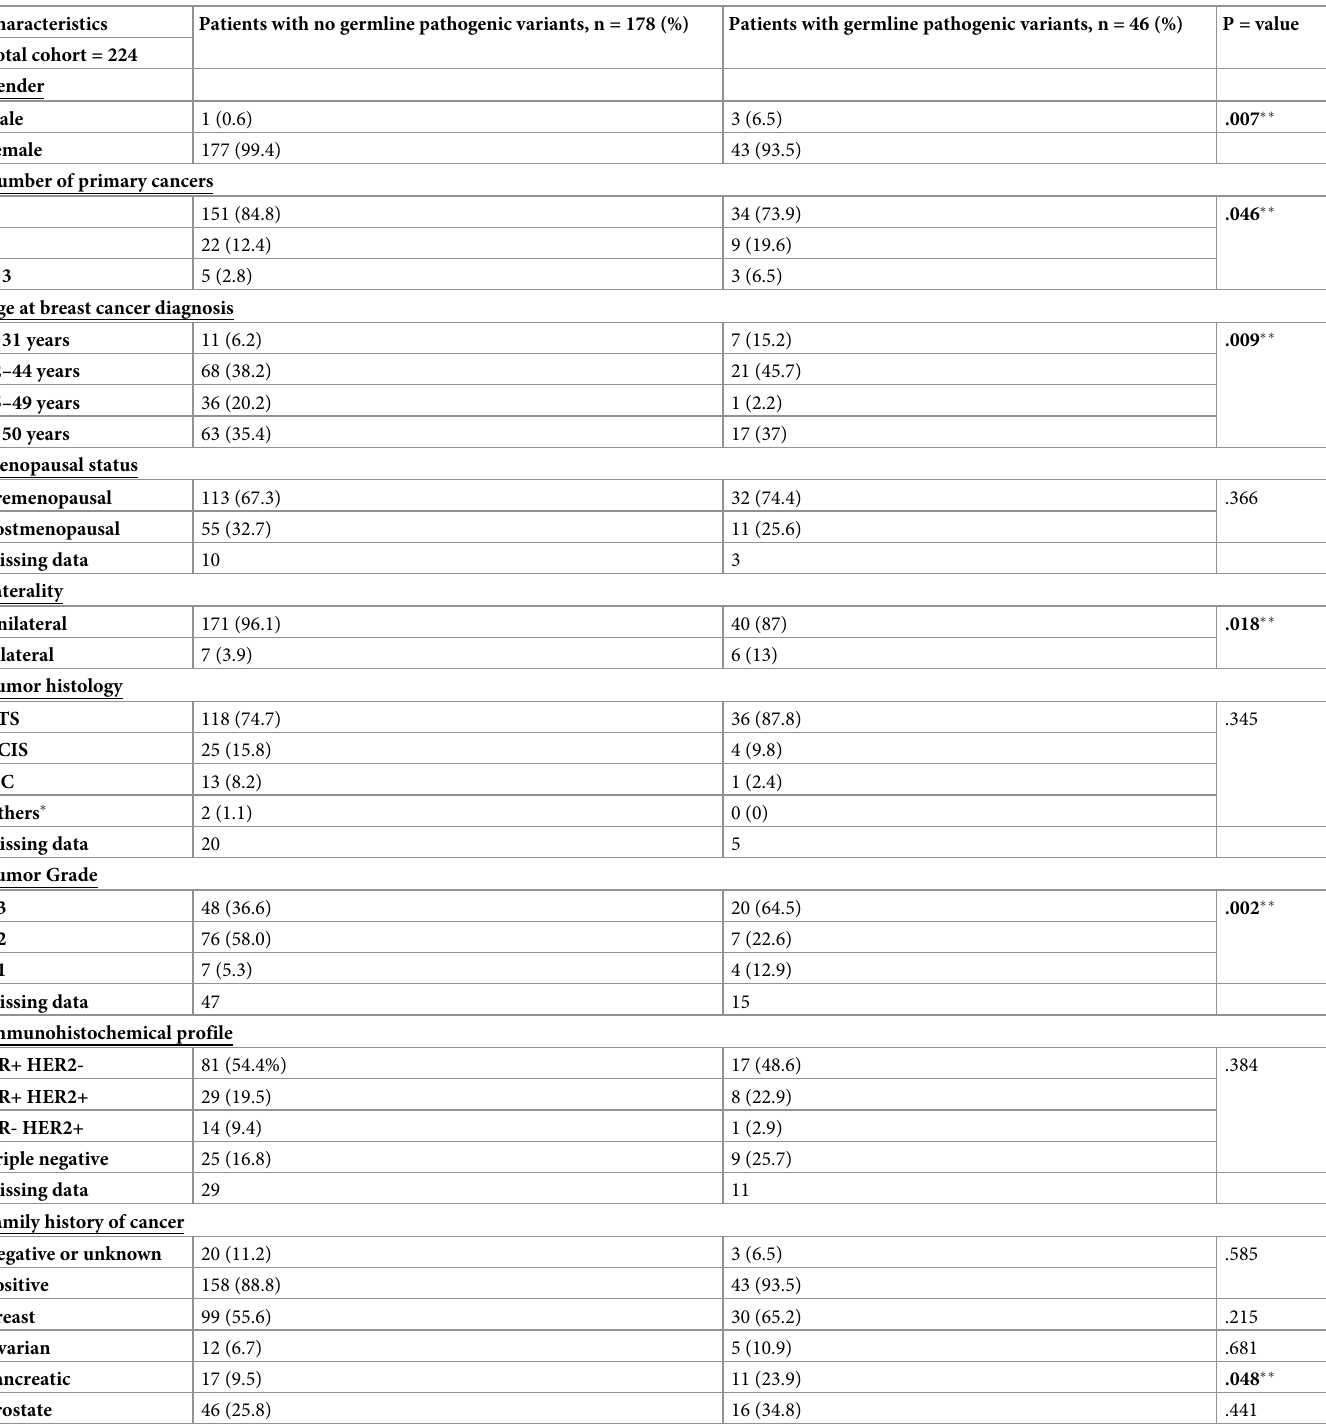
Table 1. Baseline and demographic characteristics.